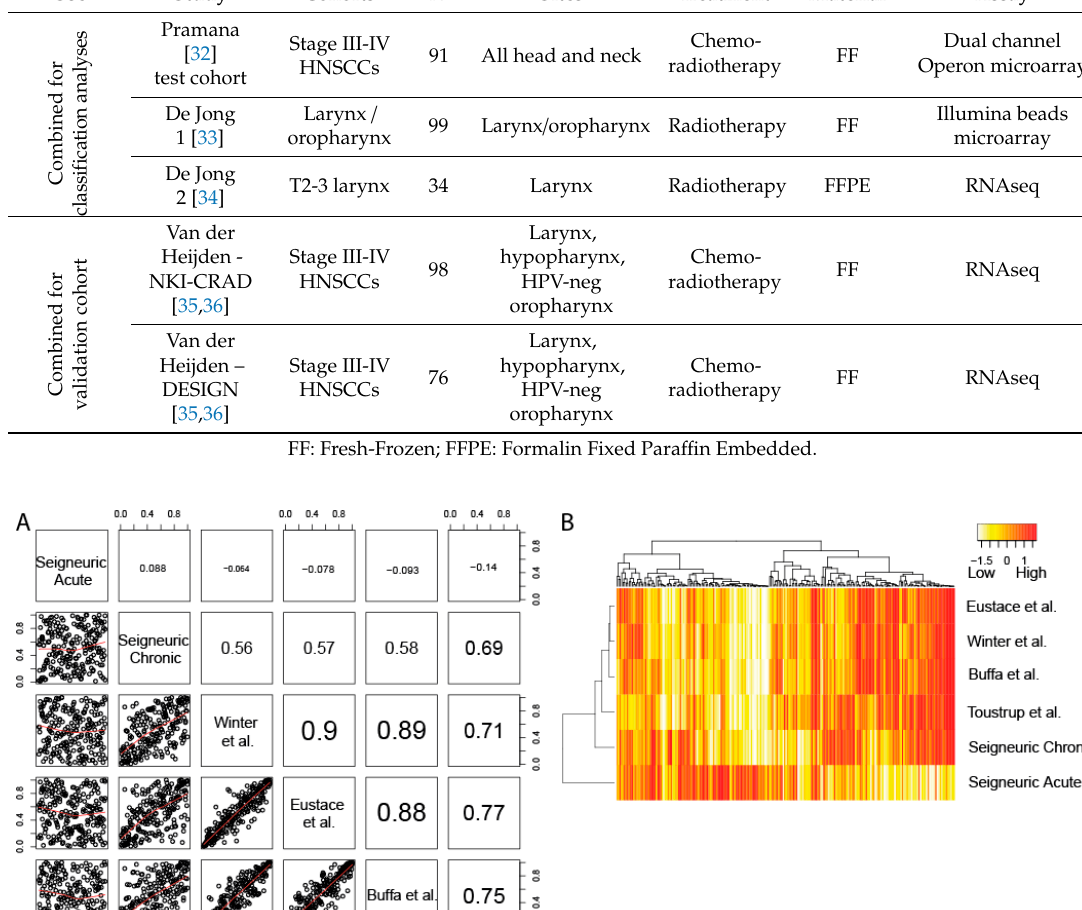
Table 1. Summary of characteristics of the five HNSCC patient cohorts.